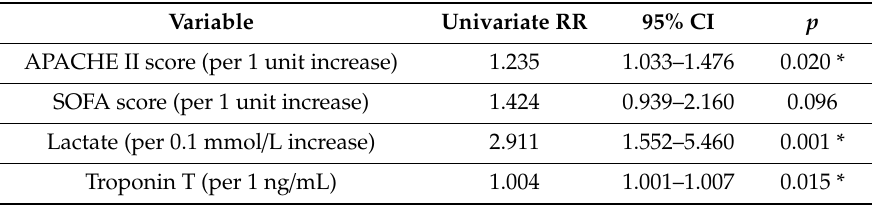
Table 2. Univariate Cox regression analysis for 28-day ICU mortality in COVID-19